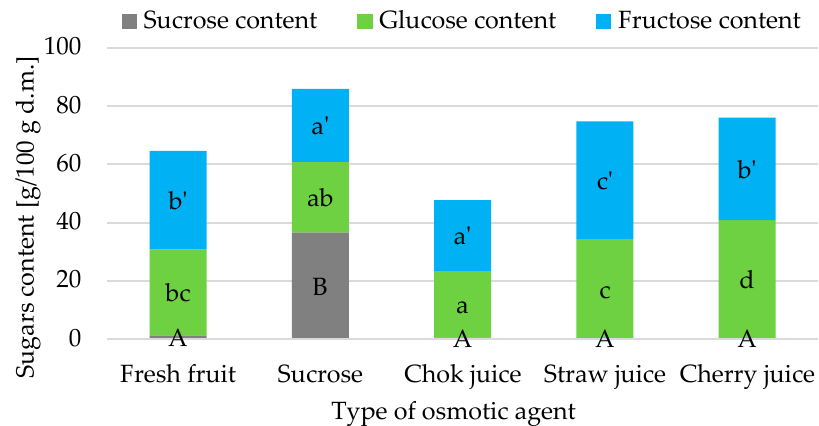
Figure 9. Effect of the type of osmotic agent (sucrose and fruit concentrates) on the sugar content of osmodehydrated strawberries. Different letters above columns show the statistical difference ( p < 0.05).